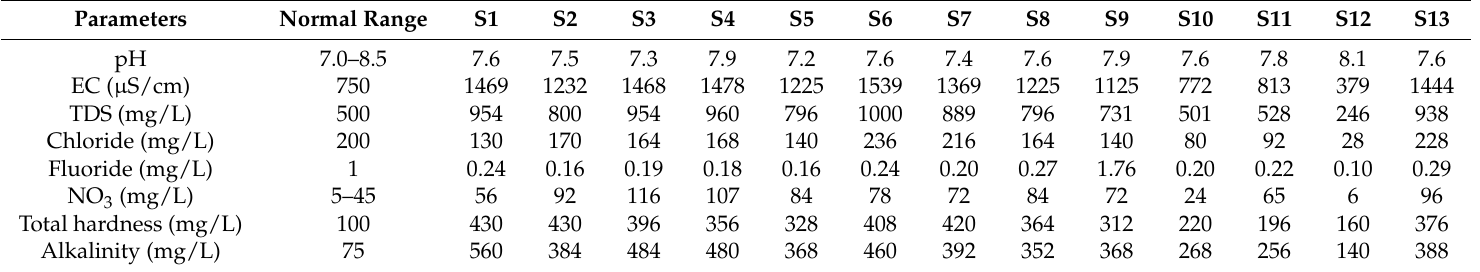
Table 2. Wastewater characteristics across sample locations in Telangana (Karimnagar), India.